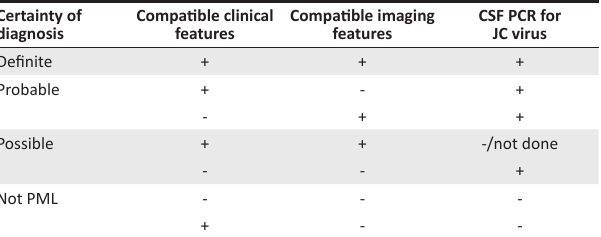
TABLE 1: Diagnostic criteria for progressive multifocal leucoencephalopathy 4 : Clinical, radiographic and laboratory data. Certainty of